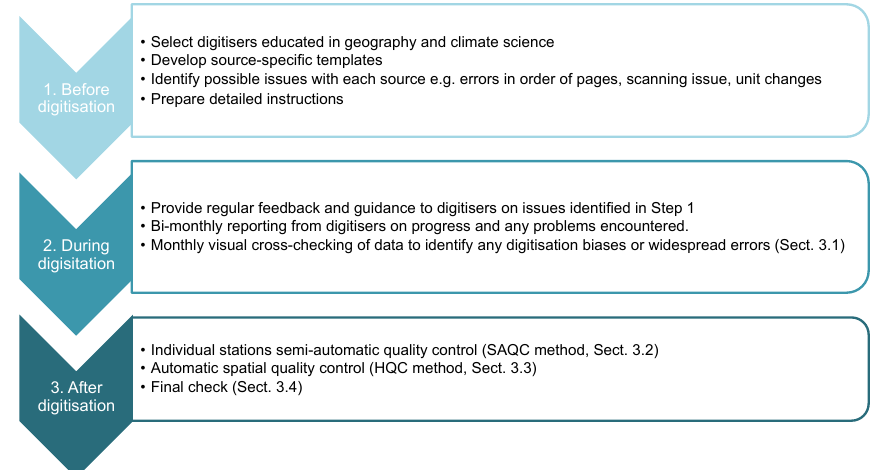
Figure 4. A schematic of the quality assurance and quality control procedures used in the development of the dataset.